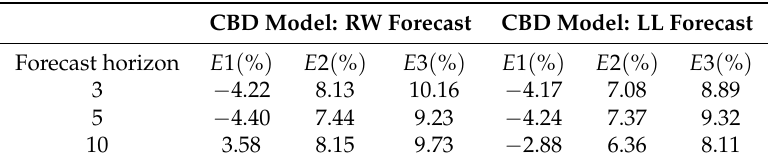
Table 2. Forecasting results of the CBD model for GB males aged 50–89 based on mortality data since 1950. RW, random walk; LL, local